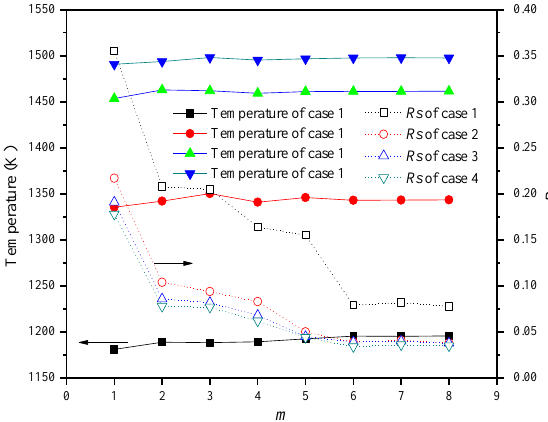
Figure 6. The flame temperatures of four cases detected by spectrometer.